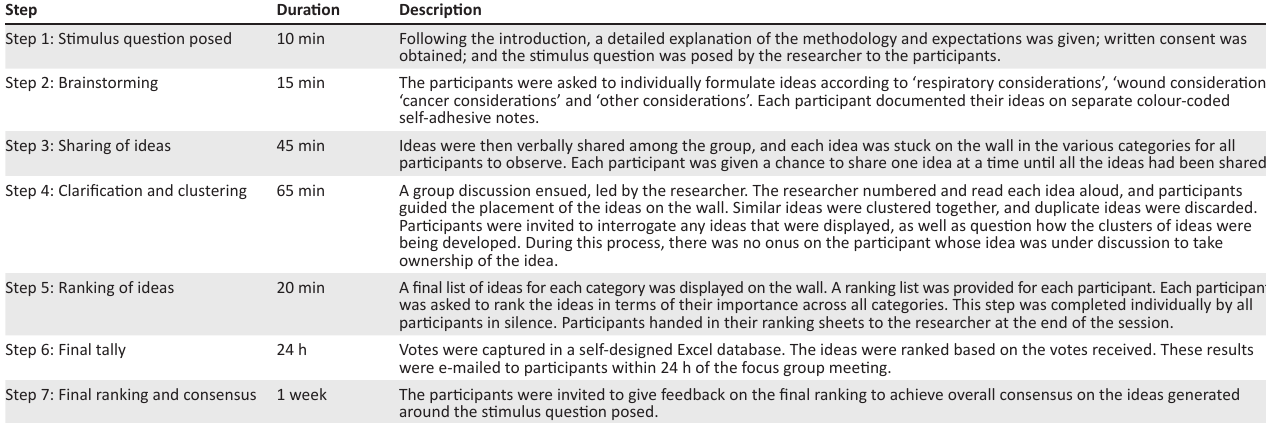
TABLE 2: Summary of the nominal group technique methodology used in the focus group session.